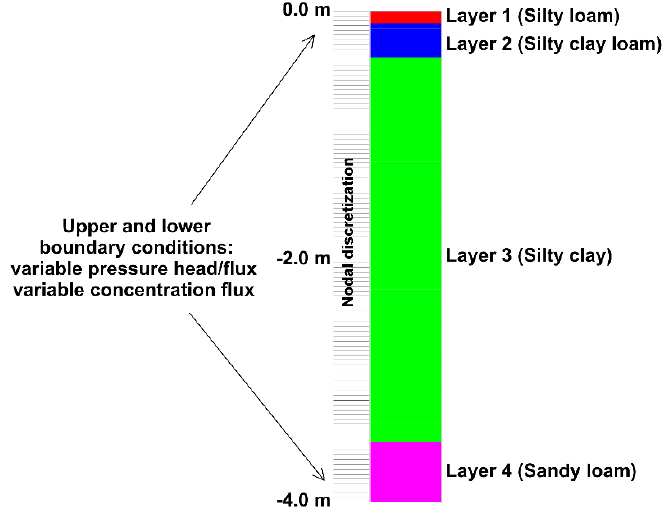
Figure 3. Scheme of the numerical model setup used to simulate both the STD and No-till + CMP experimental plots.